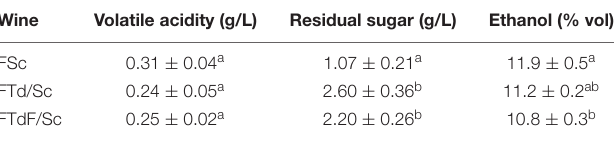
TABLE 4 | Mean values and standard deviation of the composition of Chardonnay wines by pure S. cerevisiae fermentation (FSc) and co-inoculated fermentations FTd/Sc and